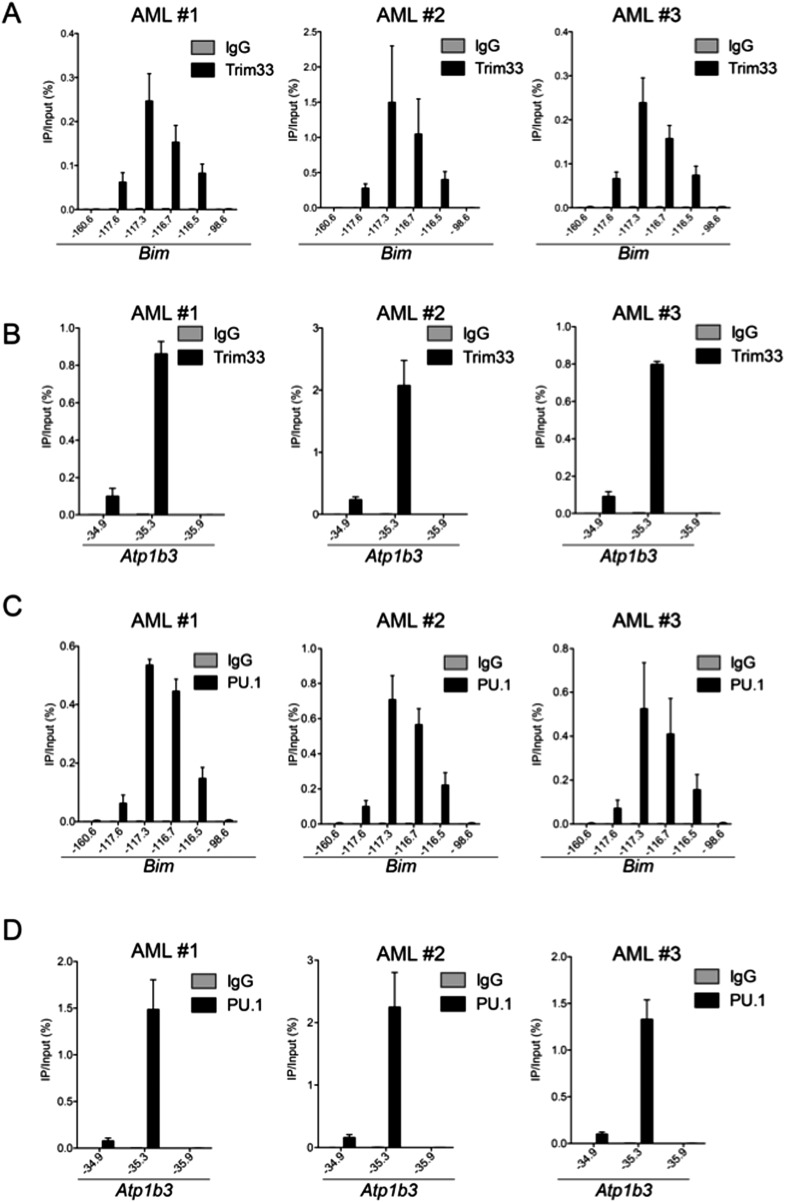
ChIP-qPCR of TRIM33 and PU.1 in 3 independent MLL-AF9/NrasG12D acute myeloid leukemia cell lines, which are all early passage cultures derived from leukemic mice.